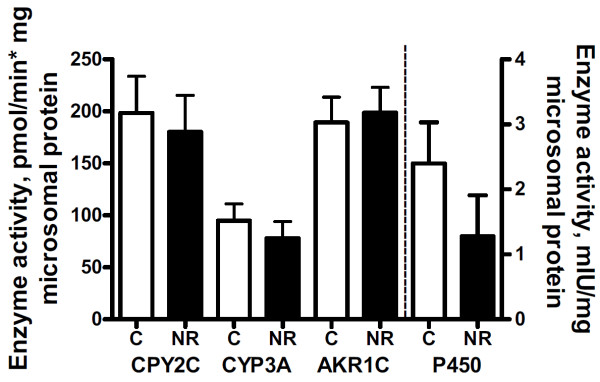
Enzyme activities from livers of aged ewe offspring of control and nutrient restricted dams for hepatic enzymes involved in progesterone metabolism: cytochrome P450 2C (CYP2C), cytochrome P450 3A (CYP3A), aldo-keto reductase 1C (AKR1C) and cytochrome P450 reductase (P450). Control (n=4, open bars) and nutrient restricted (n=4, solid bars) offspring. No treatment differences were detected. The dashed line separates activities to be read on the left versus right y-axes. There were no significant effects of treatment on the activity of any enzyme.